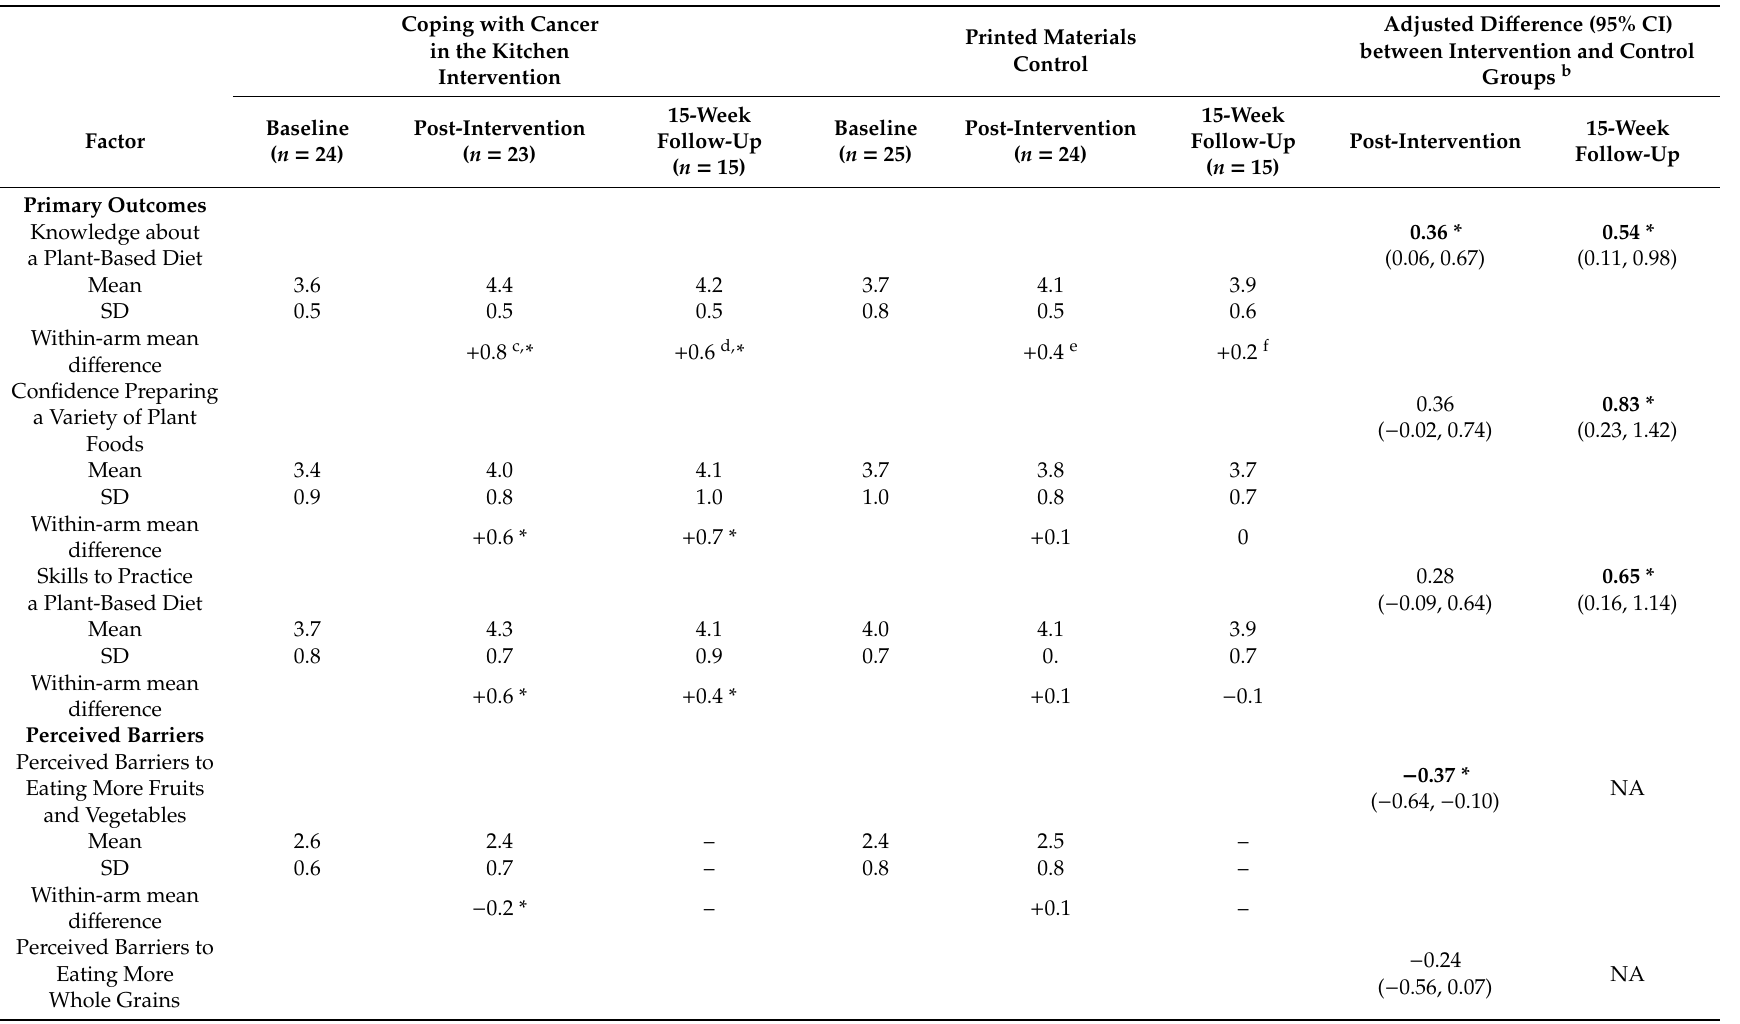
Table 3. Baseline, post-intervention (9-week), and follow-up (15-week) self-reported outcomes observed for the Coping with Cancer in the Kitchen intervention group and the printed materials